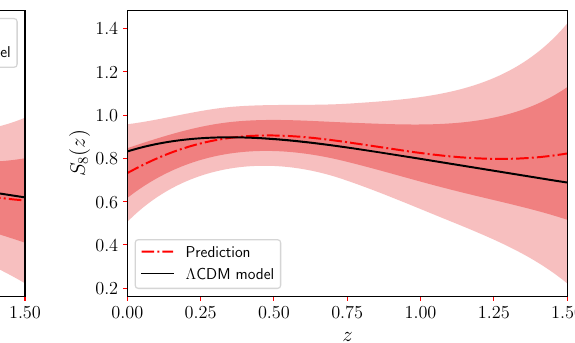
Fig. 2 Left panel: reconstruction of the function σ q remember its origin: the quotient of two continuous functions) at 1 σ and 2 σ CL obtained from our [ f σ 8 ] ( z ) and f ( z ) data sample. The dot- dashed line represents the prediction from the data. Right panel: same